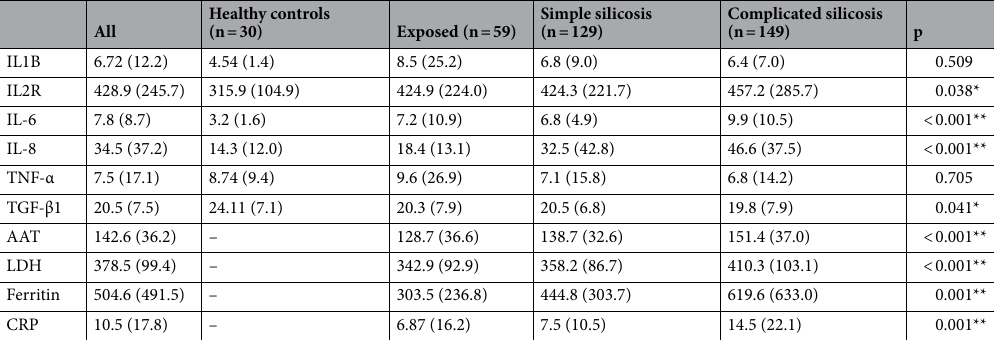
Table 3. Serum levels of the different biomarkers in control groups and silica-exposed patients. with and without silicosis. IL1β Interleukin 1 beta, IL2R interleukin 2 receptor subunit alpha, IL-6 Interleukin 6, IL-8 interleukin 8, TNF-α Tumour necrosis factor alpha, TGF-β1 Transforming growth factor-beta 1, AAT alpha-1 antitrypsin, LDH lactate dehydrogenase, CRP C-reactive protein. Statistical significance was determined using χ 2 test and ANOVA test for qualitative and continuous variables; respectively. *p < 0.05; **p < 0.001.